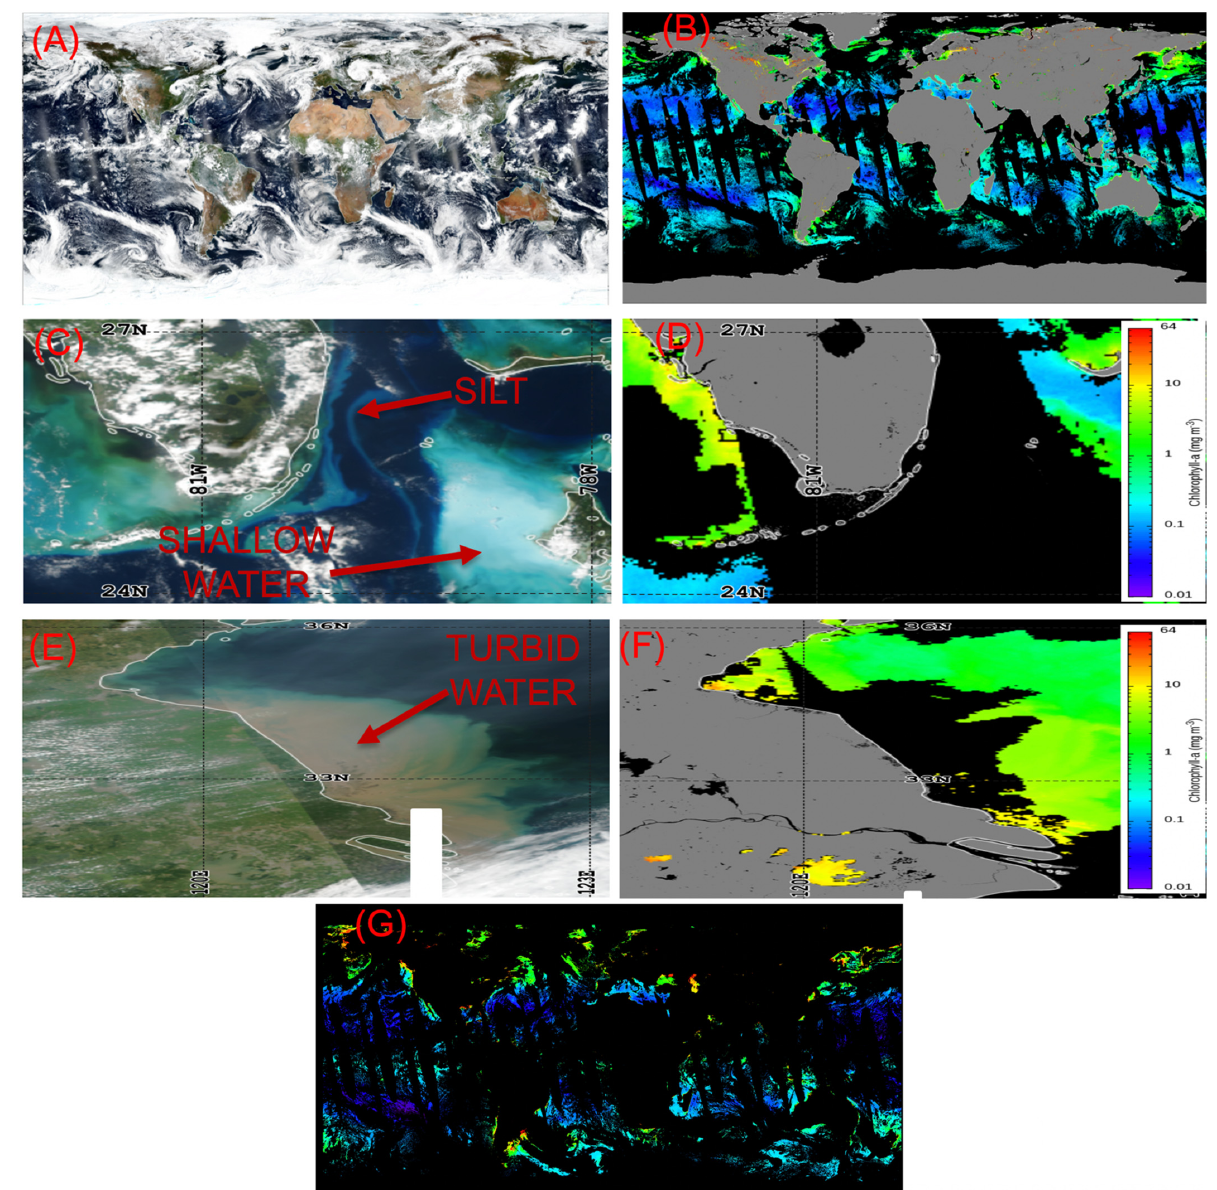
Figure 1. ( A ) a NOAA global VIIRS RGB image for September 14, 2017; ( B ) same as ( A ), but for the NOAA global chlorophyll-a (Chl-a) image; ( C ) a portion of VIIRS RGB image around southern Florida and nearby waters; ( D ) same as ( C ), but for Chl-a image; ( E ) a portion of RGB image covering parts of turbid water areas in eastern coastal area of China; ( F ) same as ( E ), except for the Chl-a image, and ( G ) the NASA global Chl-a image for the same day.